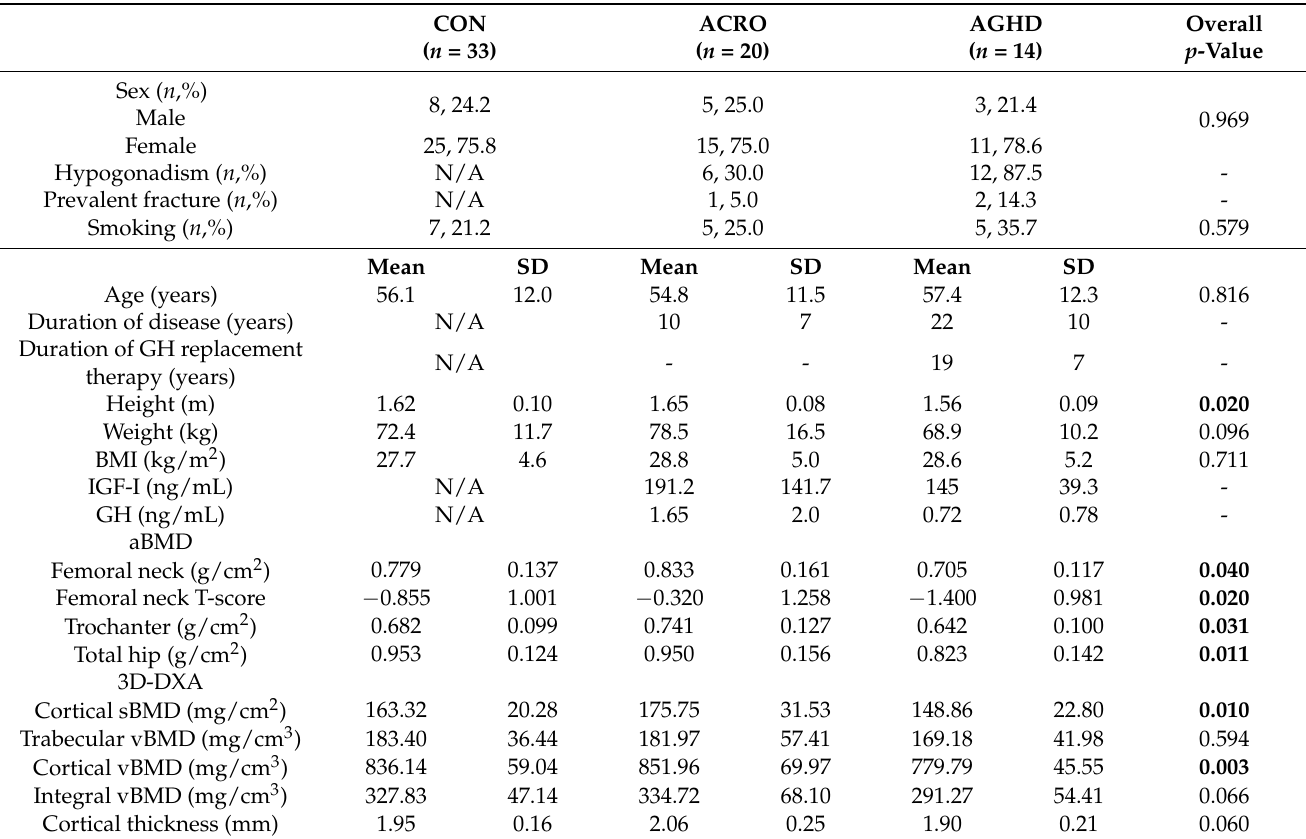
Table 1. Descriptive characteristics of the study